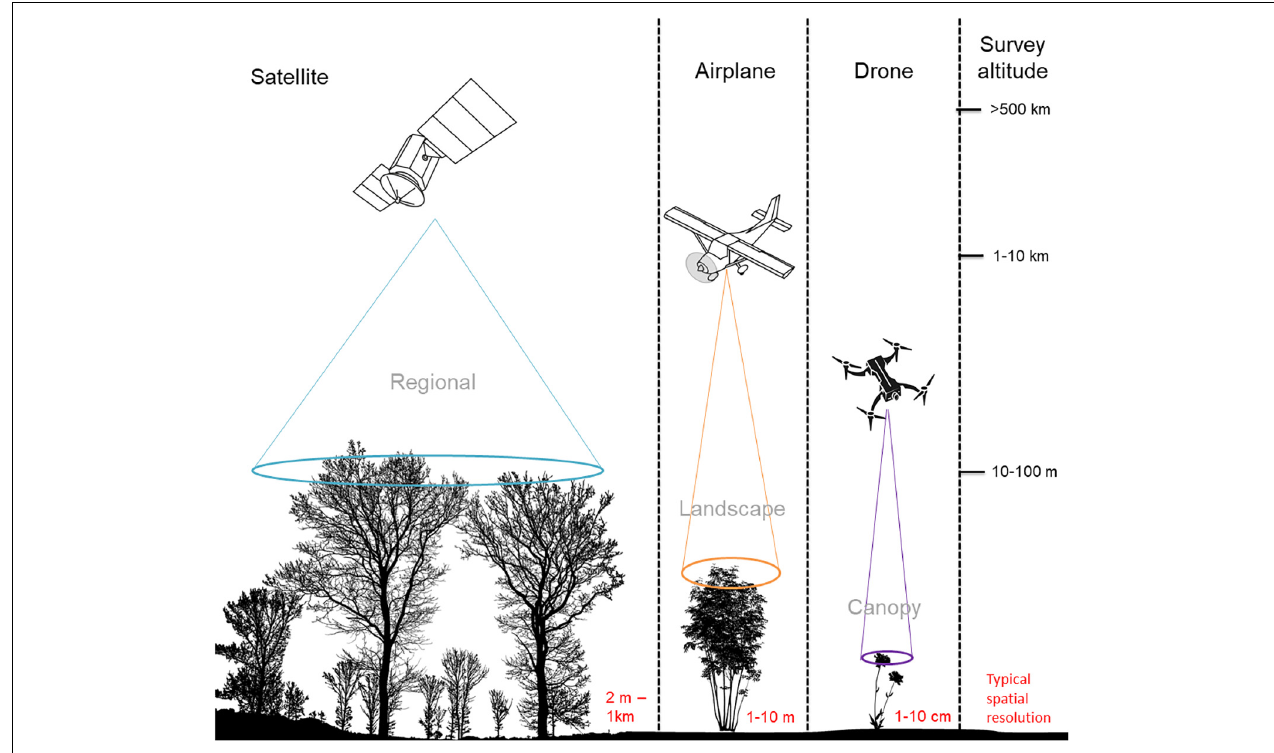
FIGURE 1 | The approximate operating altitudes of satellite-, airplane-, and drone-based imaging platforms. The corresponding fields of view used to capture vegetation from these different altitudes illustrate the extent of the landscape that can be viewed from a single image by sensors onboard each imaging